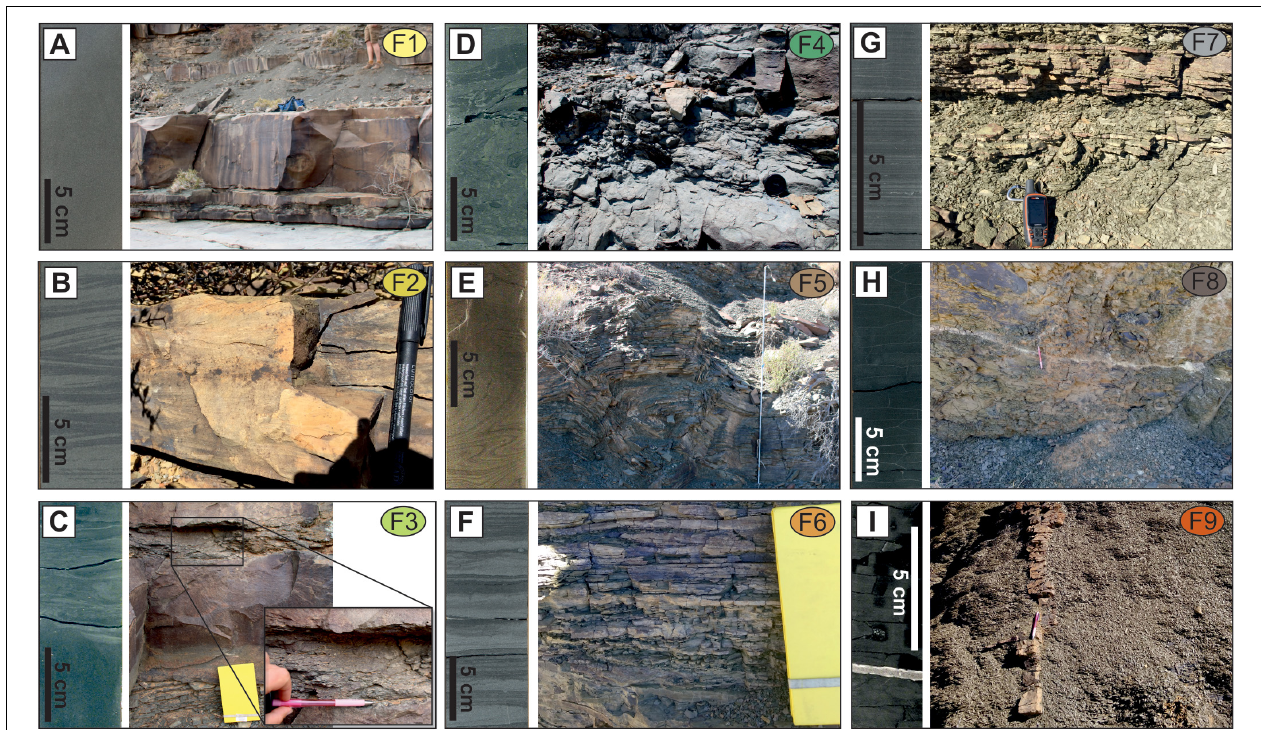
FIGURE 3 | Representative outcrop and core photographs of observed sedimentary facies. (A) Structureless sandstone (F1). Bag for scale (˜50 cm). (B) Structured sandstone (F2). (C) Hybrid bed (F3) with lower clean division and upper mudclast-rich division. (D) Debrite (F4). (E) Deformed strata (F5). (F) Thinly interbedded sandstone and siltstone (F6). (G) Thin-bedded siltstone and mudstone (F7). (H) Mudstone (F8), note the tuff layer in the center of the mudstone package in the outcrop photograph. (I) Discordant sandstone (F9) interpreted as injectite, pen for scale (10